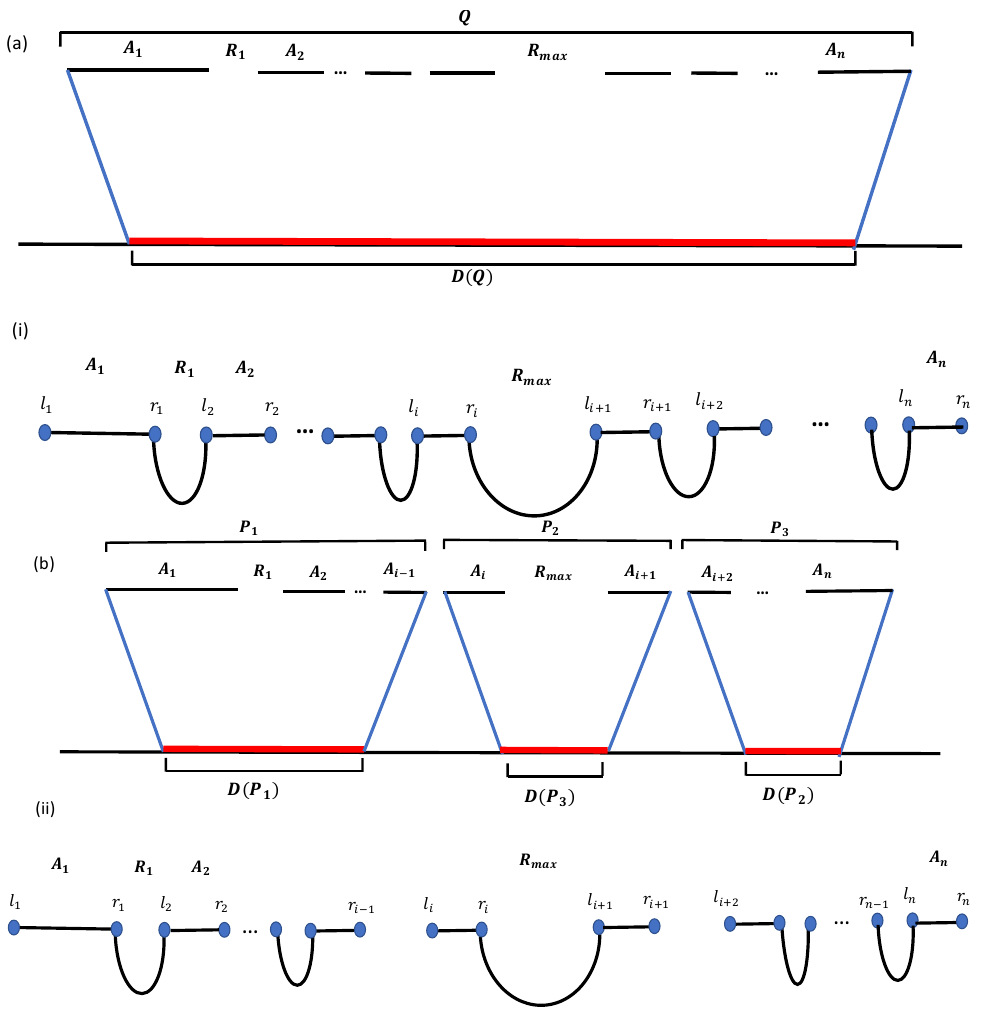
Figure 30 . Two sets of initial operators contributing to (2.11), and the corresponding endpoint configurations γ . In (a), initial operators nontrivial everywhere in D ( Q ) develop a void in R